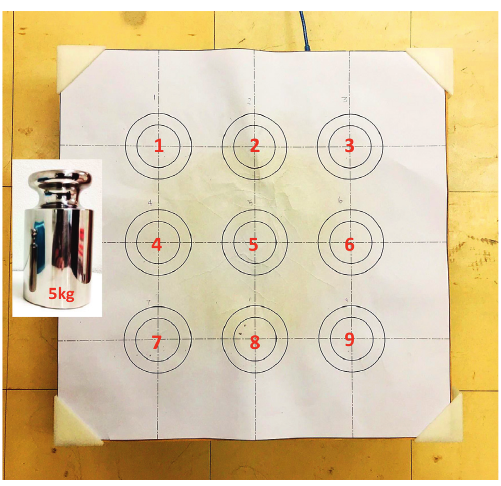
Figure 3: Nine positions and a 5kg weight for testing SBAP